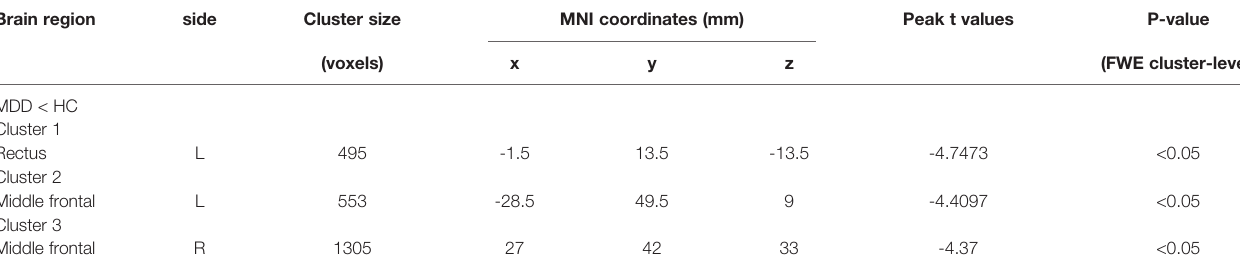
TABLE 2 | Regional GM volume changes in patients with MDD compared to healthy controls.